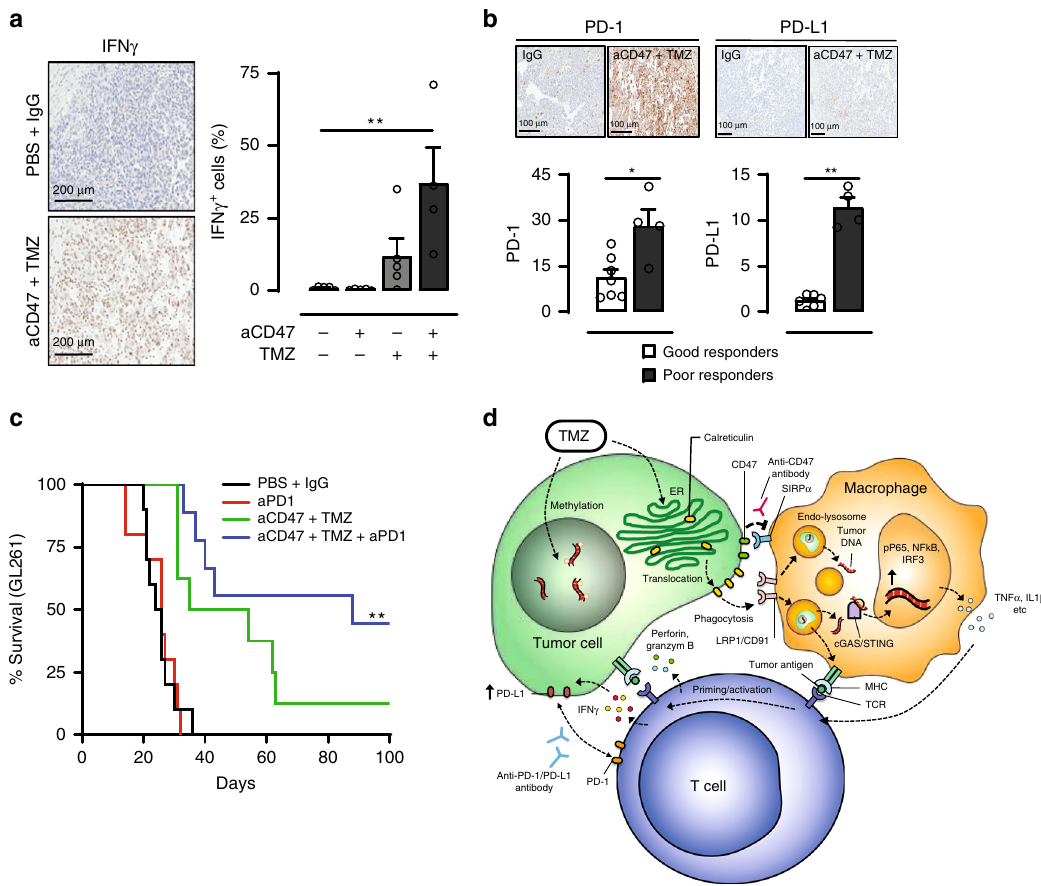
Fig. 6 The anti-GBM effect of combined TMZ and anti-CD47 antibody treatment is augmented by adjuvant PD-1 blockade. a Combination TMZ and anti-CD47 antibody treatment signi fi cantly elevated the level of IFN γ within tumors. Scale bar = 200 μ m, Combo, n = 4; other groups, n = 5. ** p < 0.01, one-side ANOVA with Bonferroni post hoc correction. b PD-1 (good responders, n = 7; poor responders, n = 4) and PD-L1 (good responders, n = 6; poor responders, n = 4) expression levels were notably elevated in GBM treated with combination TMZ and anti-CD47 antibody treatment. ** p < 0.01,